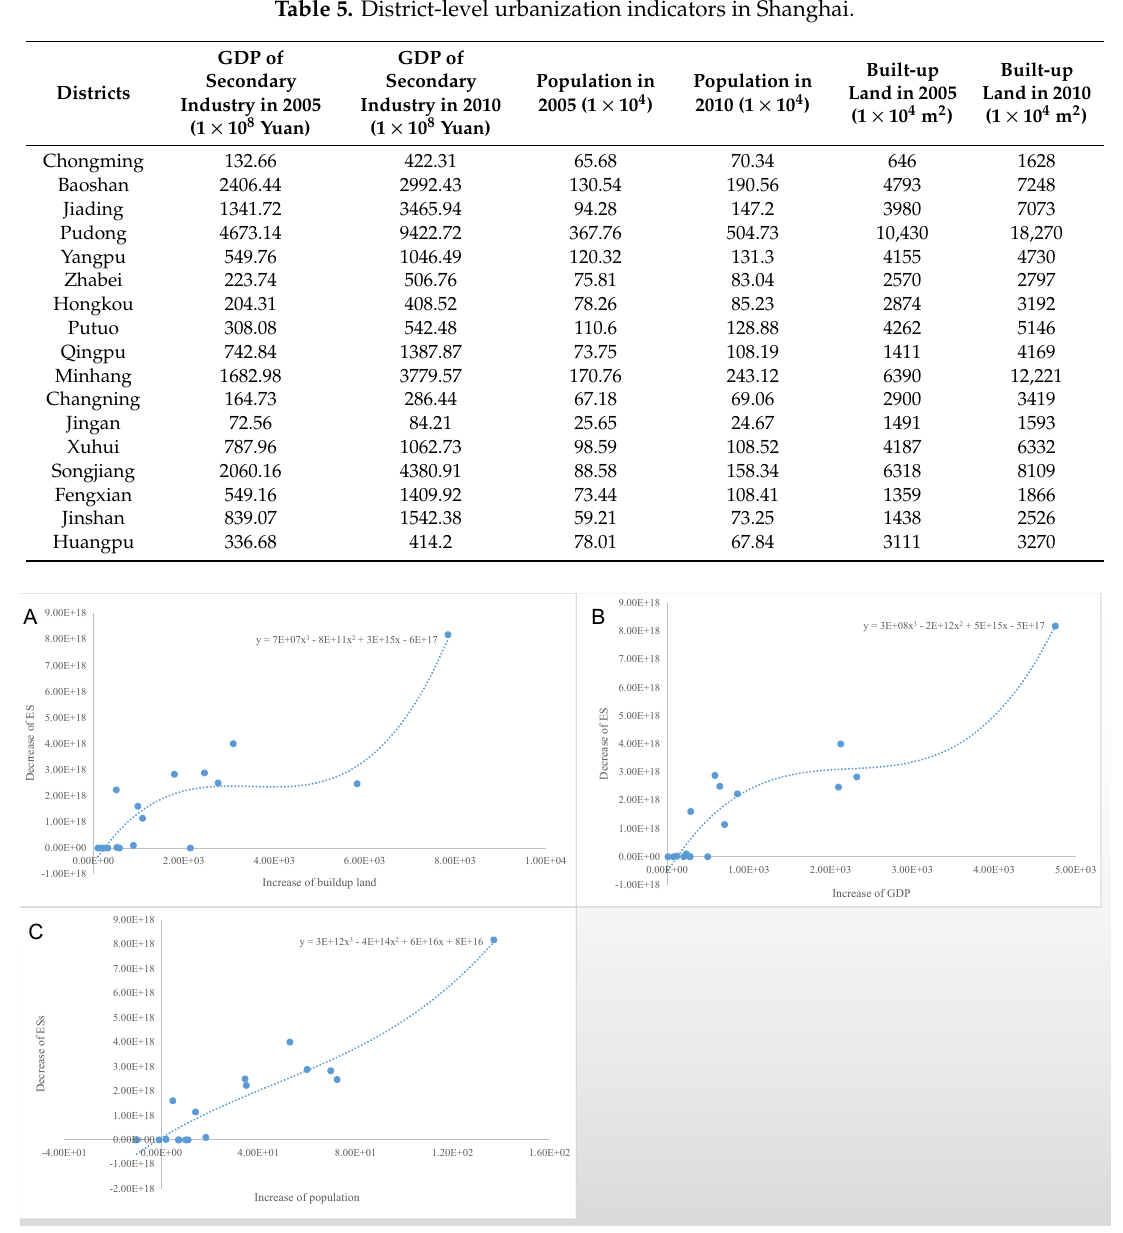
Table 5. District-level urbanization indicators in Shanghai.